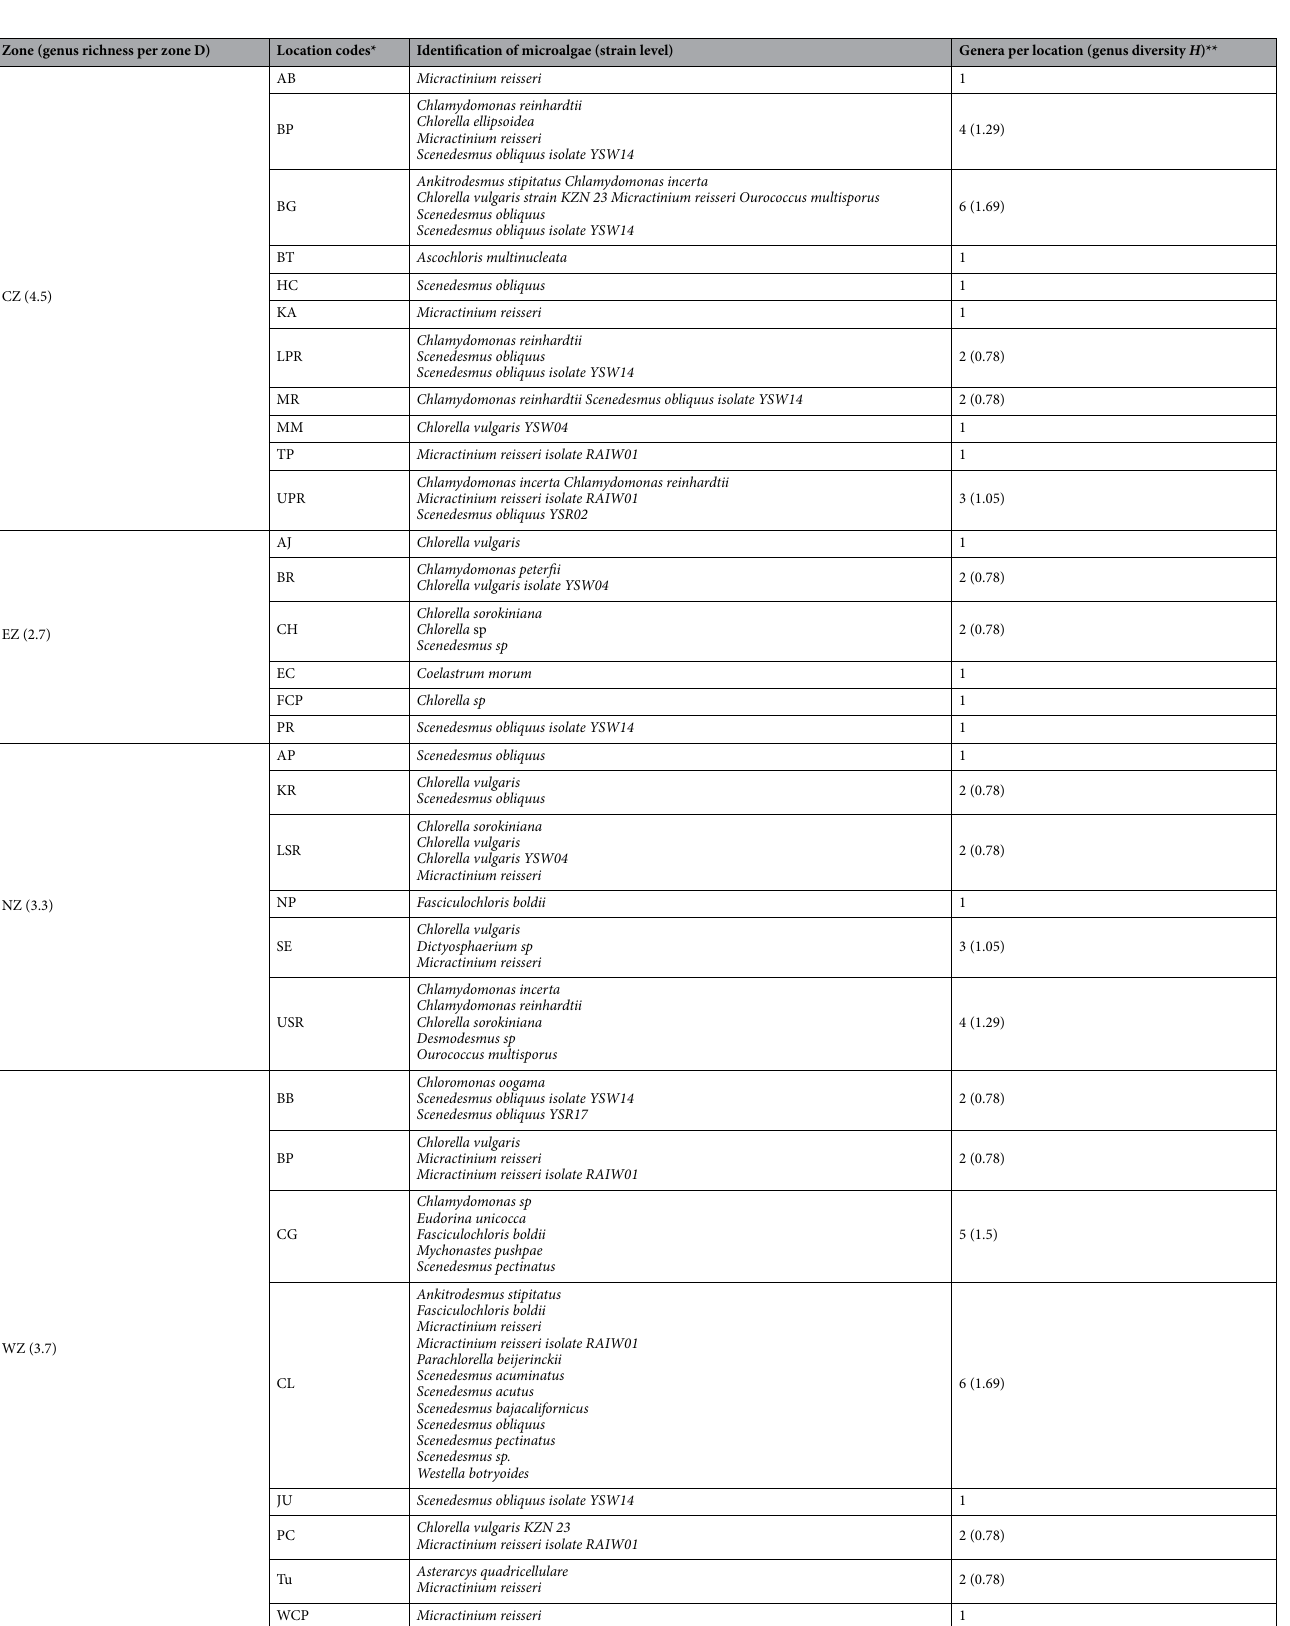
Table 2. Location wise diversity of microalgal species. *Location laboratory codes. **Diversity is calculated when there was only more than 1 isolate, D- Menhinick’s index, H -Shannon’s